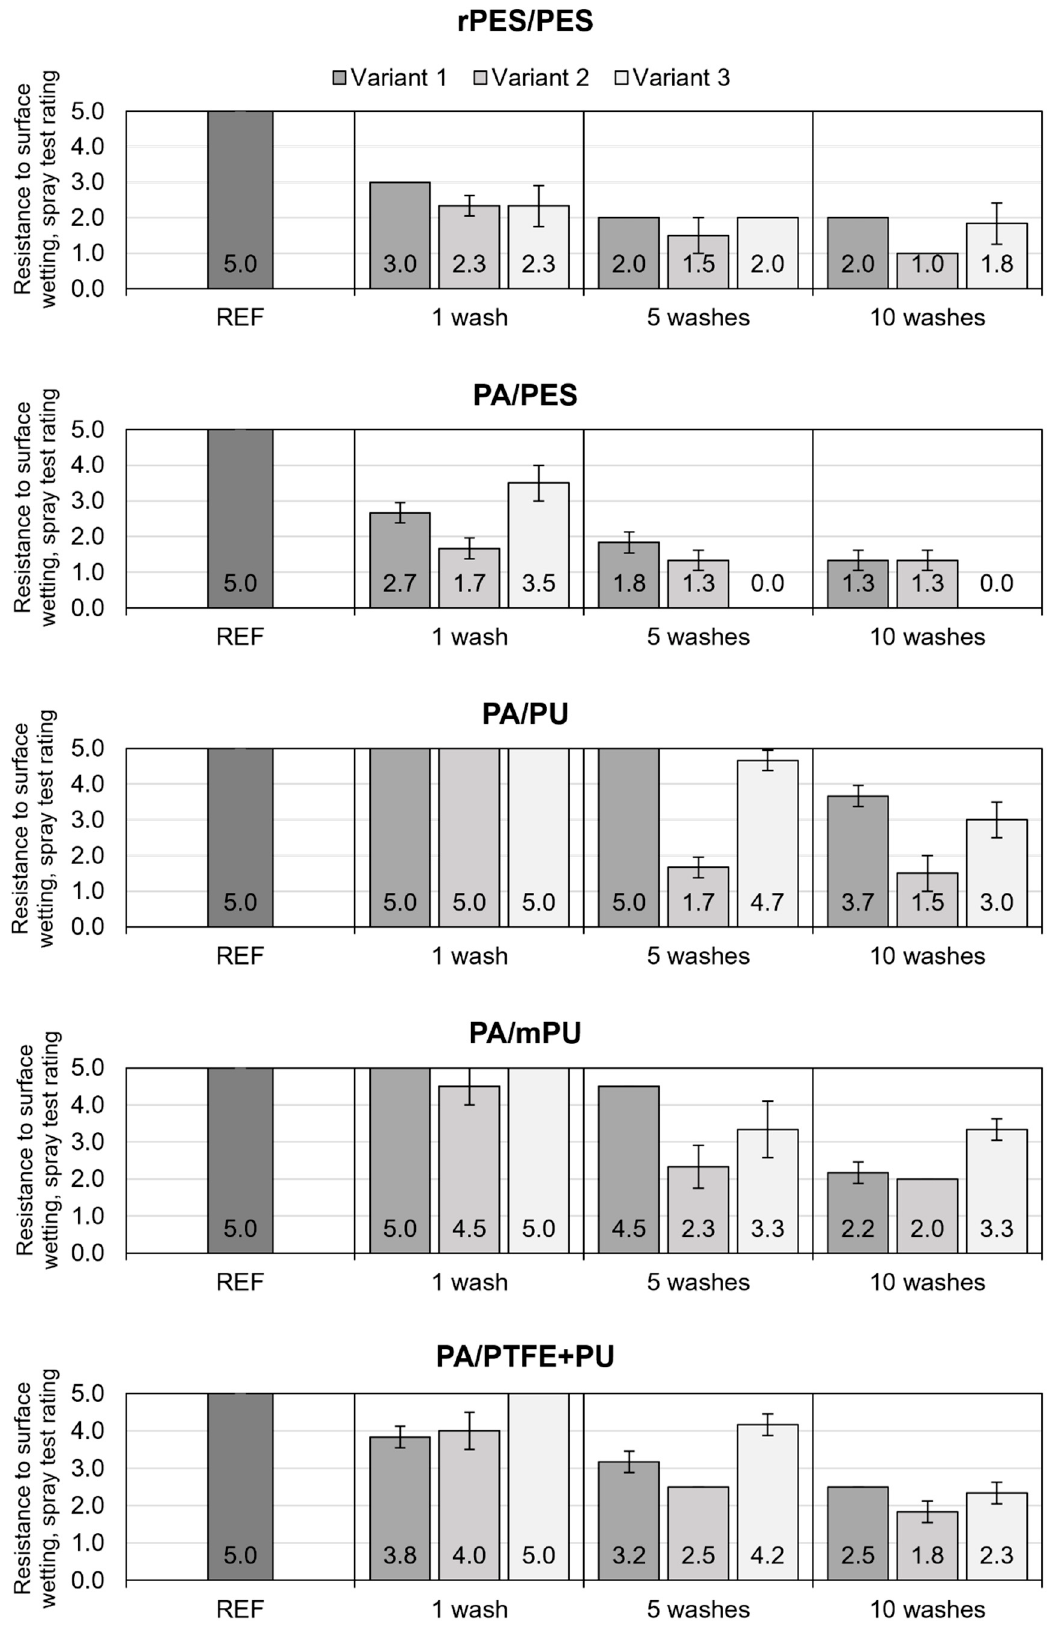
Figure 5. Resistance to surface wetting (spray test) results.